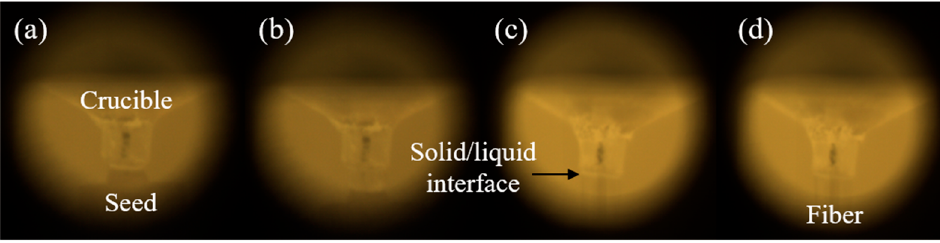
Figure 2. Real-time images of seeding ( a , b ) and stable crystal growth ( c , d ) by the CCD camera.